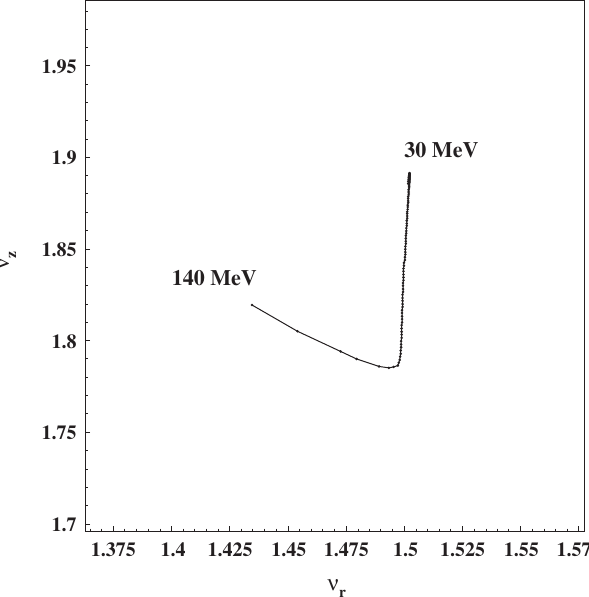
FIG. 3. Tunes of the isotope production cyclotron for H þ 2 energies from 30 to 140 MeV.